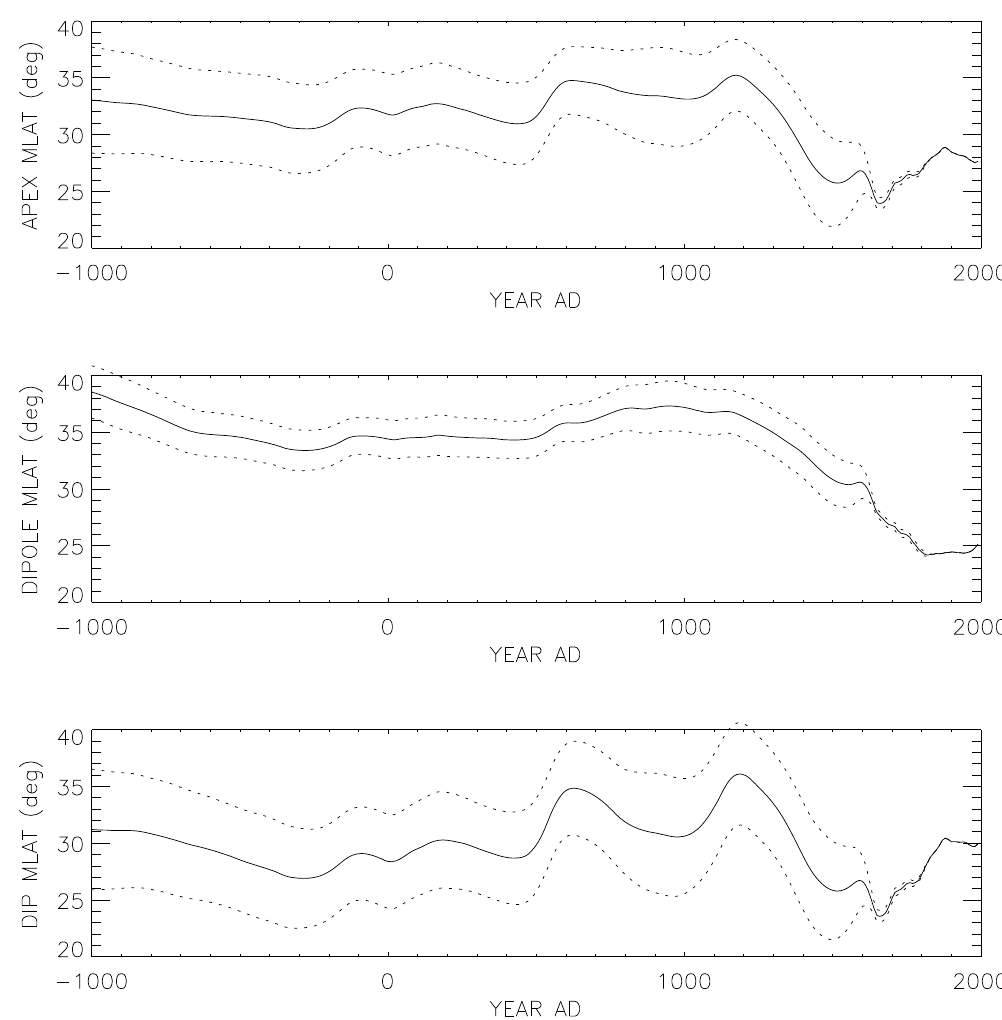
Fig. 6. Magnetic latitudes of Kyoto (35 (cid:1) N, 135 (cid:1) E) for the last 3000 years. From top to bottom, the apex latitude, dipole latitude, and dip latitude are shown. The possible errors (dotted lines) increase before 1600